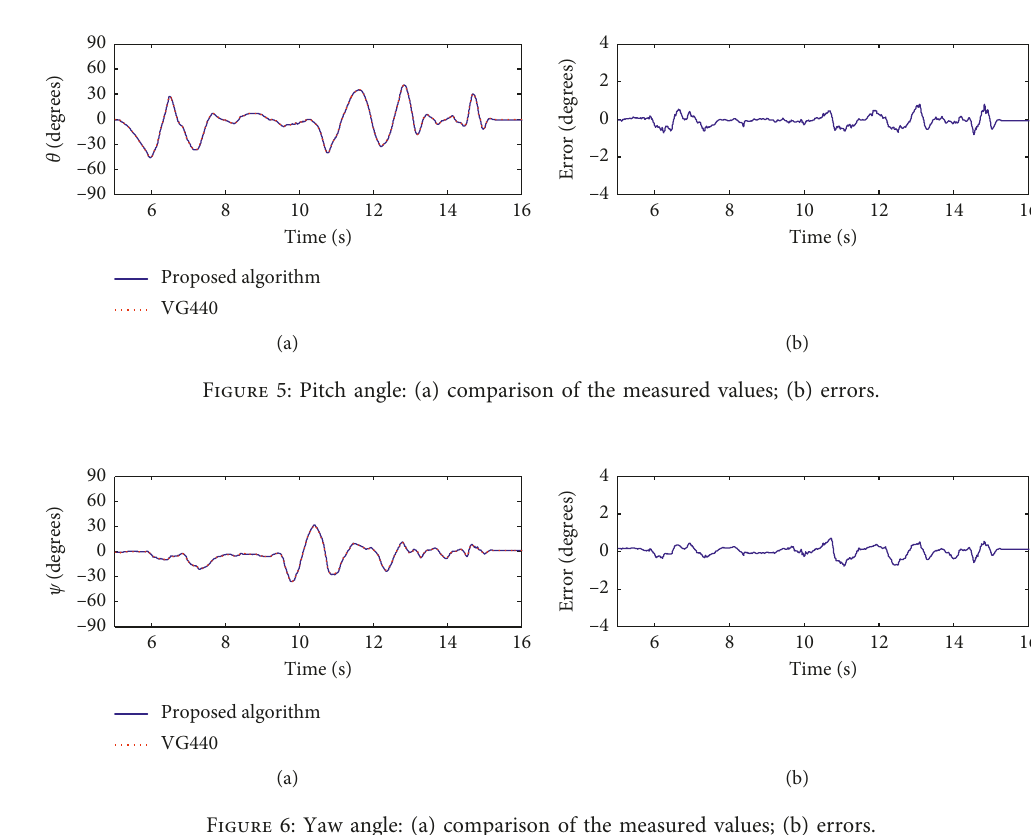
Figure 6: Yaw angle: (a) comparison of the measured values; (b)